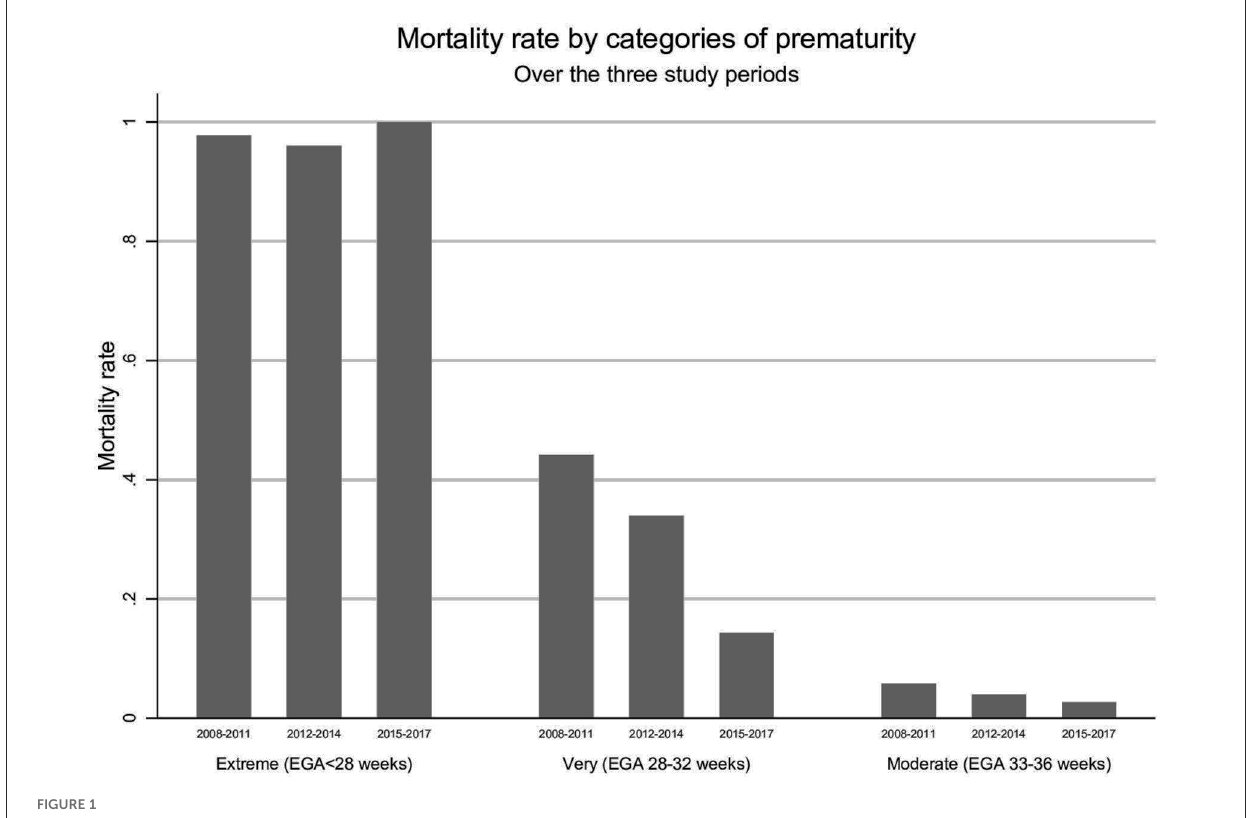
FIGURE1 Mortality rate by categories of prematurity and by study